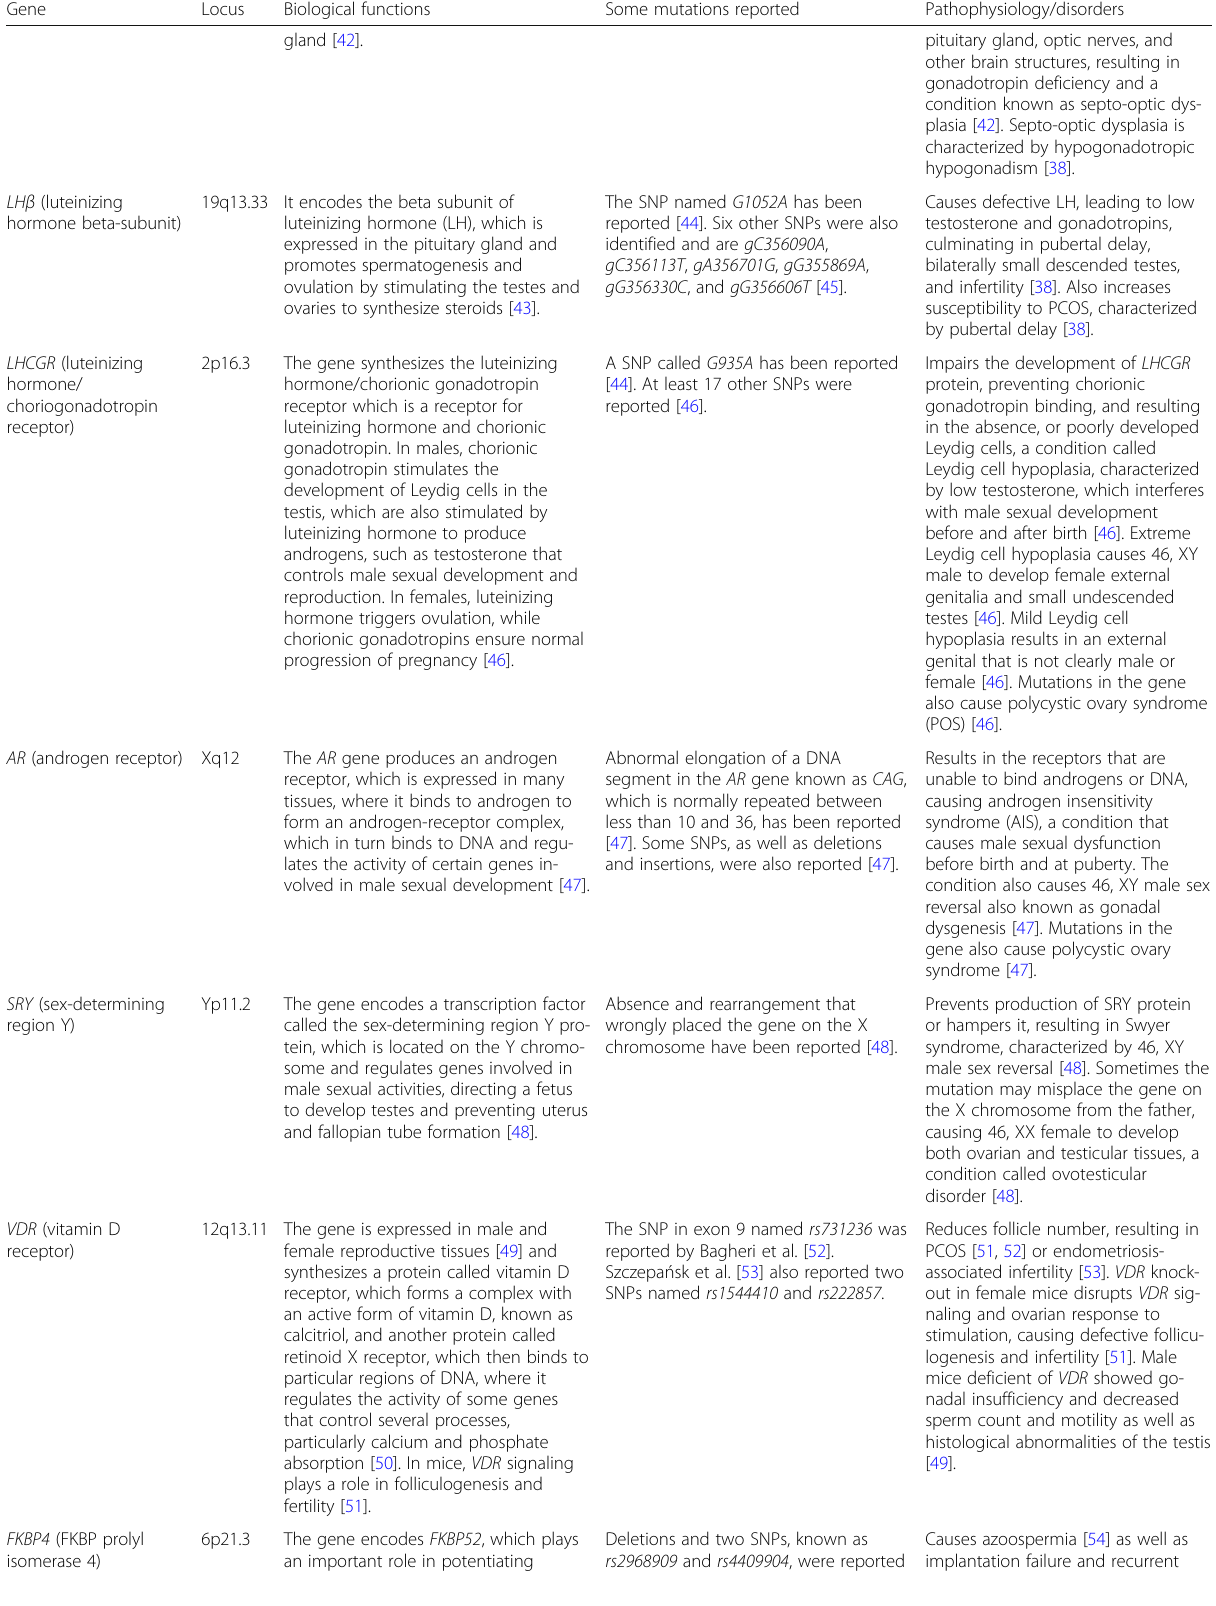
Table 1 Genes predisposing to syndromic infertility